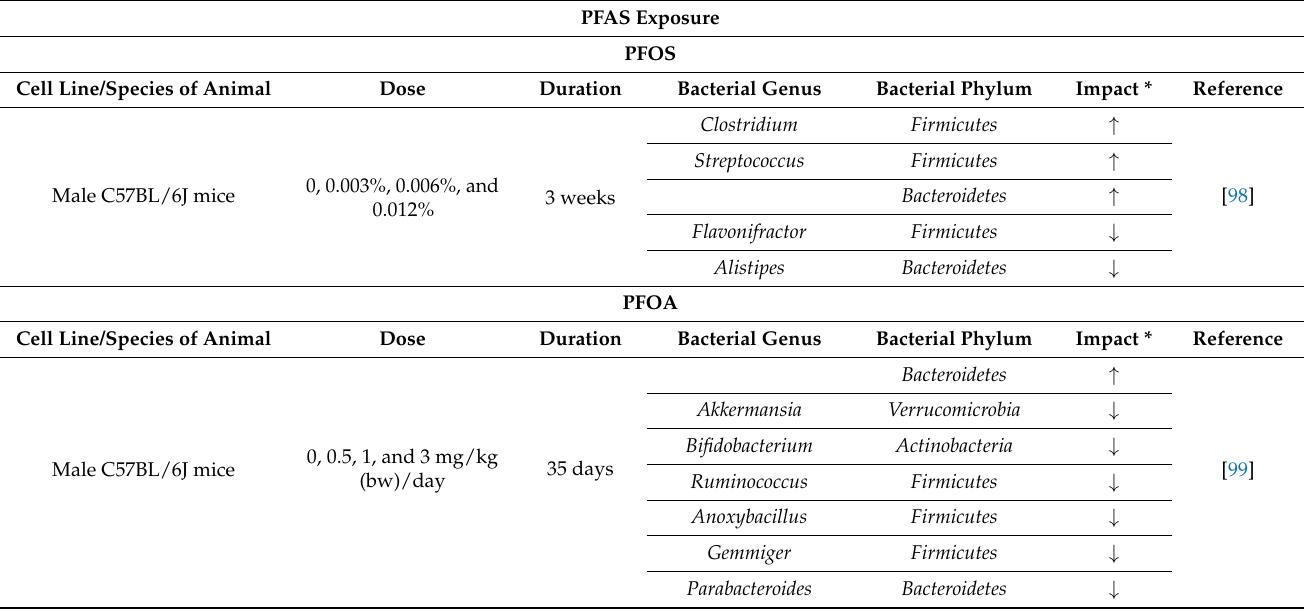
Table 4. Studies on exposure to PFAS and its relationship with the intestinal